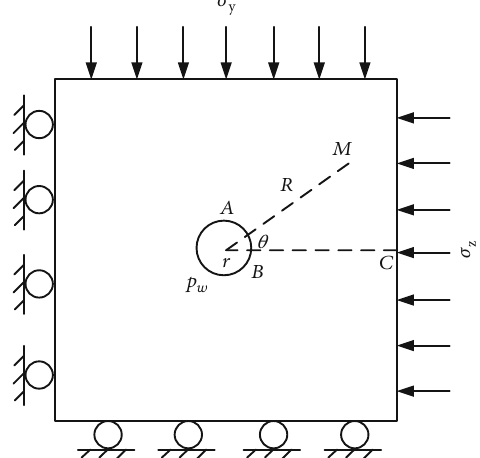
Figure 4: Numerical model of hydraulic fracturing of rock mass.